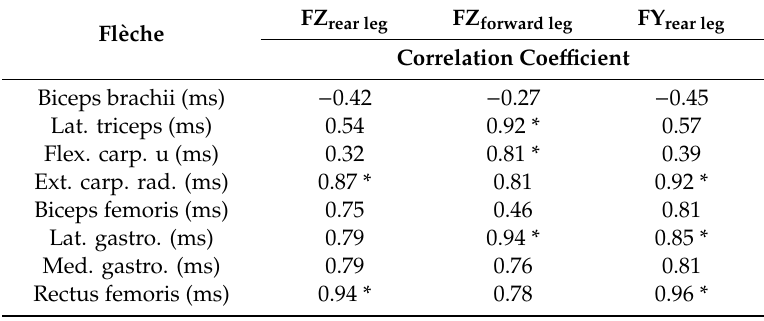
Table 4. Correlation coe ffi cients of the mean values until the peak electromyography (EMG) signal for the vertical (FZ) and horizontal components (FY) of the signal recorded in the rear leg and forward legs during attacks executed by the fl è che in the interval from t 0 to t K .